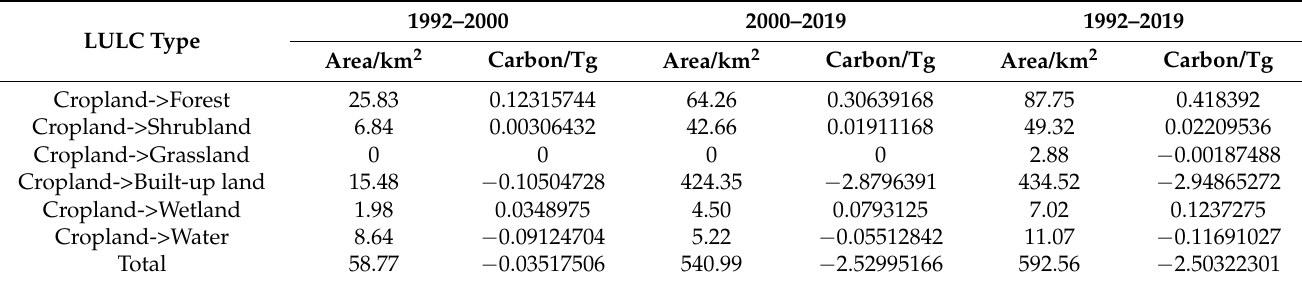
Table 4. Changes in carbon storage from the conversion of cropland to other land types.